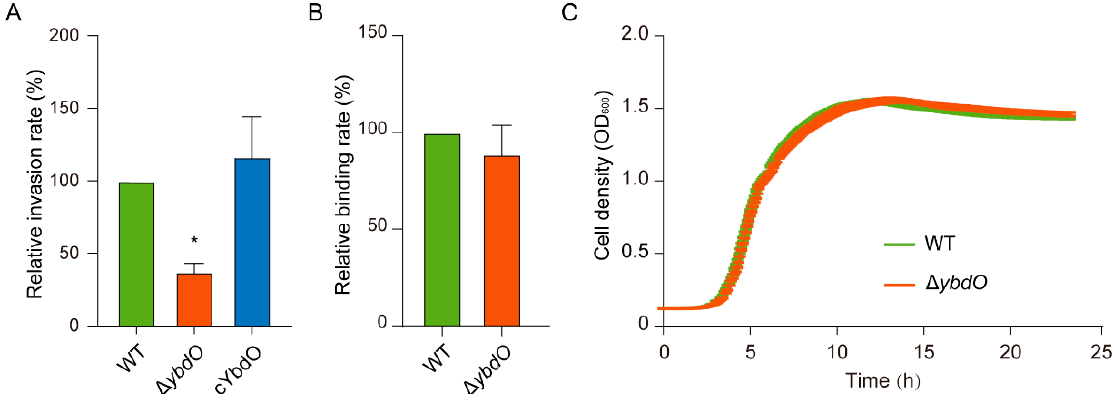
Figure 2. ybdO deletion reduces HBMEC invasion by E. coli K1. ( A ) Differences in the invasion abilities of the Δ ybdO and cybdO strains relative to that of the WT strain. ( B ) Differences in the binding abilities of the ∆ ybdO and cybdO strains relative to that of the WT strain. ( C ) Growth of WT and ∆ ybdO strains in BHI medium. Data were obtained from three independent experiments and analyzed using Student’s t -test. * p < 0.05.